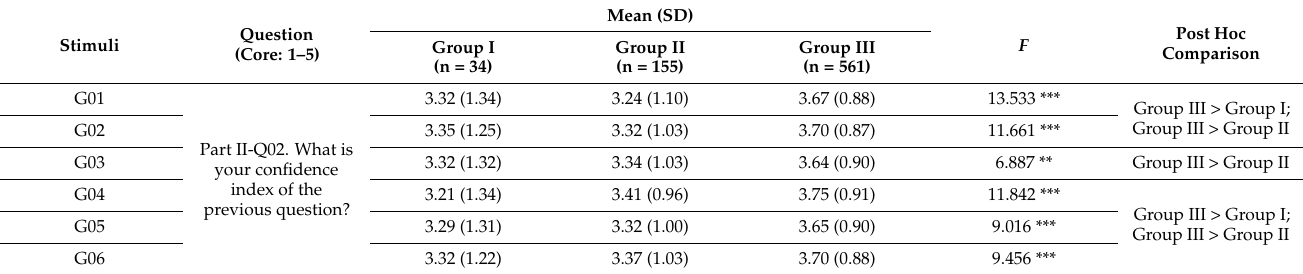
Table 5. Cognitive differences between different